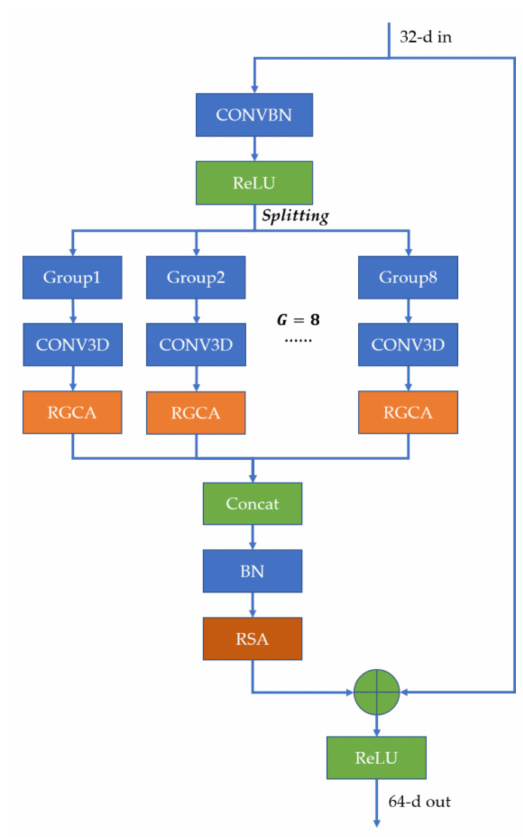
Figure 9. General structure of the building block in RGCSA (taking block 1 as an